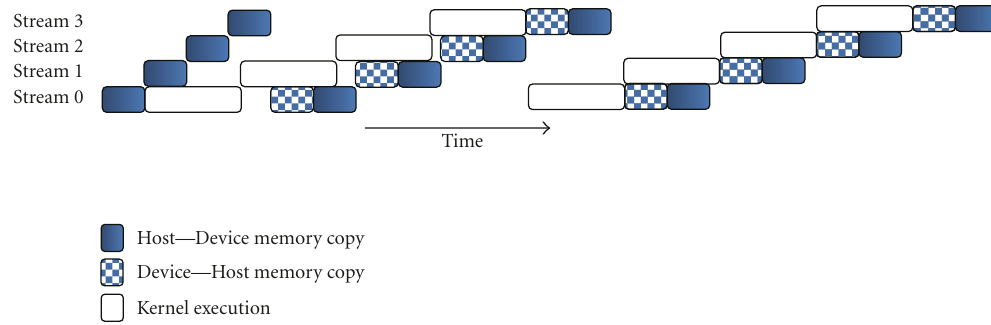
Figure 6: Illustration of streaming execution. This diagram assumes zero streaming overheads which would also a ff ect performance.